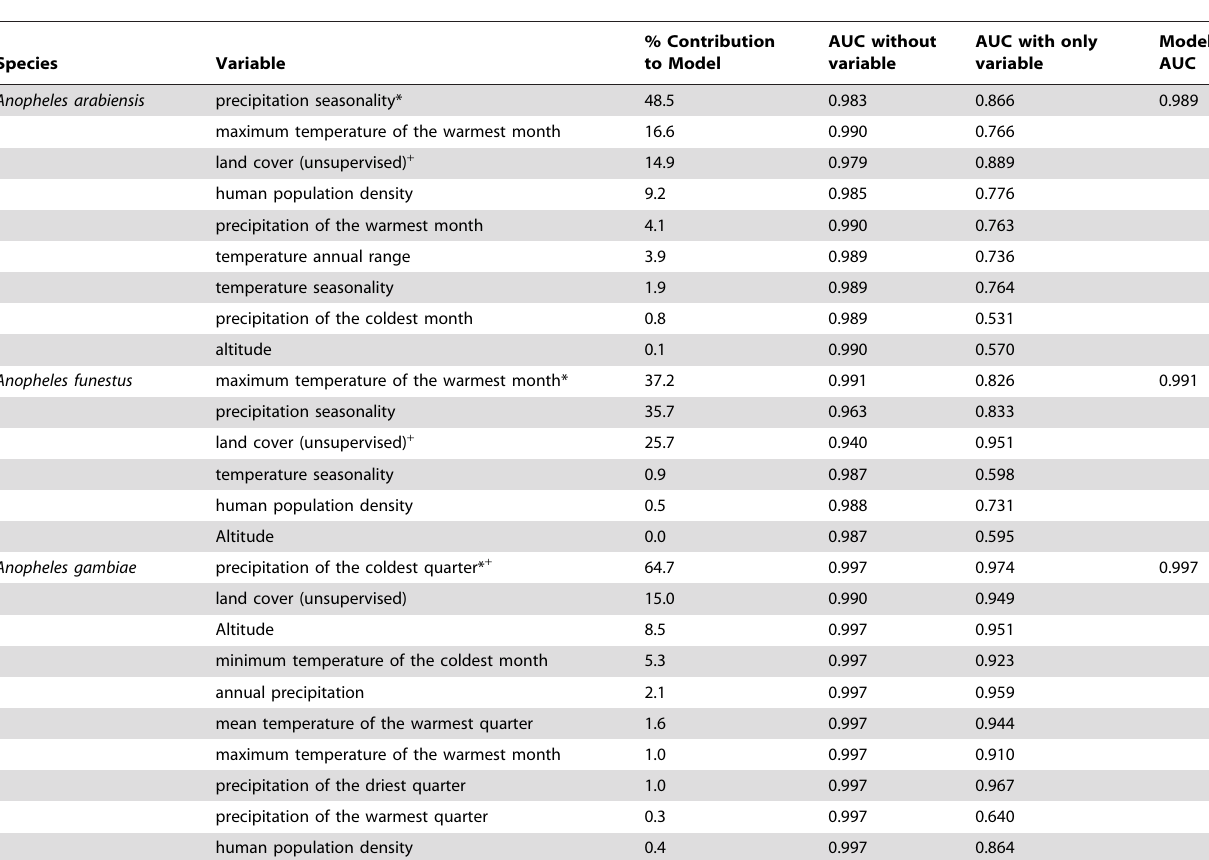
Table 2. Contribution of environmental variables to malaria vector species’ niche